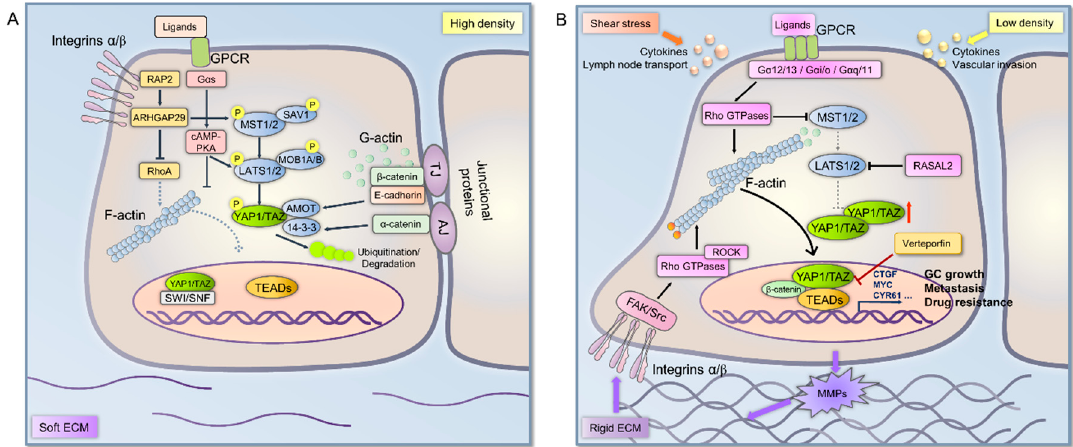
Figure 1. Proposed mechanical cues regulates Hippo signaling pathway in gastric tumorigenesis. ( A ) Hippo pathway turn on and YAP1 inactivation under soft ECM or high cell density. Cells reside in soft ECM and ECM exerts low mechanical force on gastric cells. Integrin signaling is inactivated. RAP2/ARHGAP29 axis activates MST1/2 and LATS1/2, as well as other Hippo pathway components. The GPCR/G α s directly phosphorylates LATS1/2 via a cAMP/PKA dependent